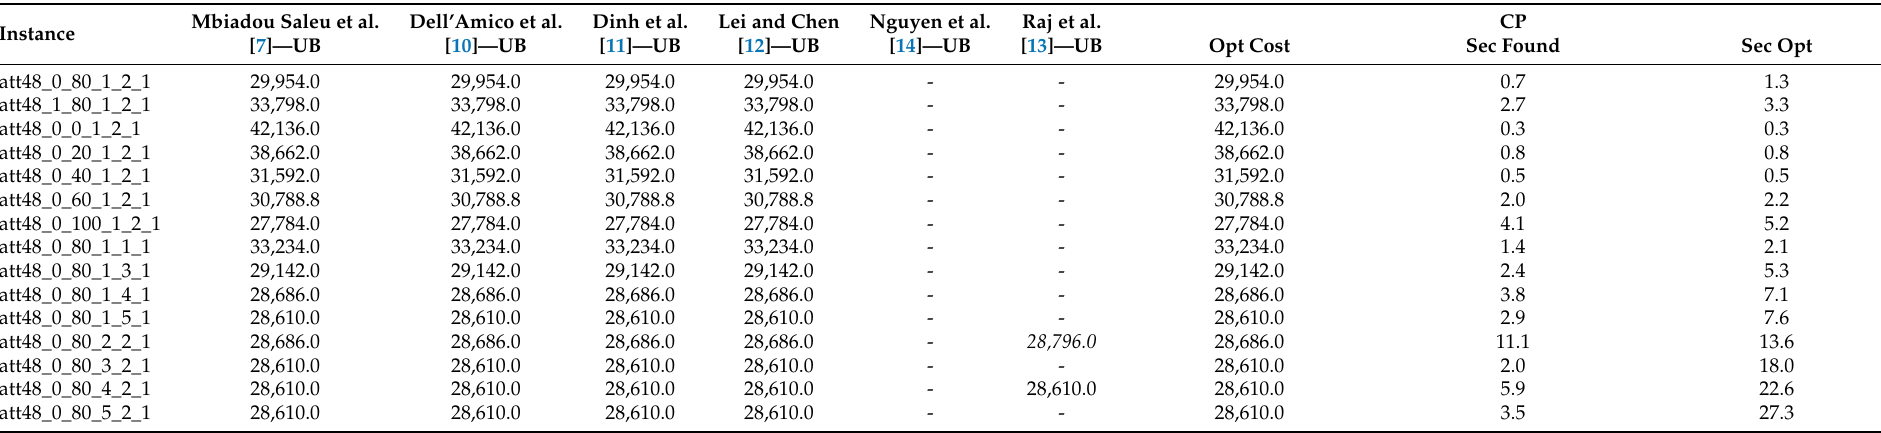
Table 2. Instances originated from att48 in [7]. Optimal solution costs.